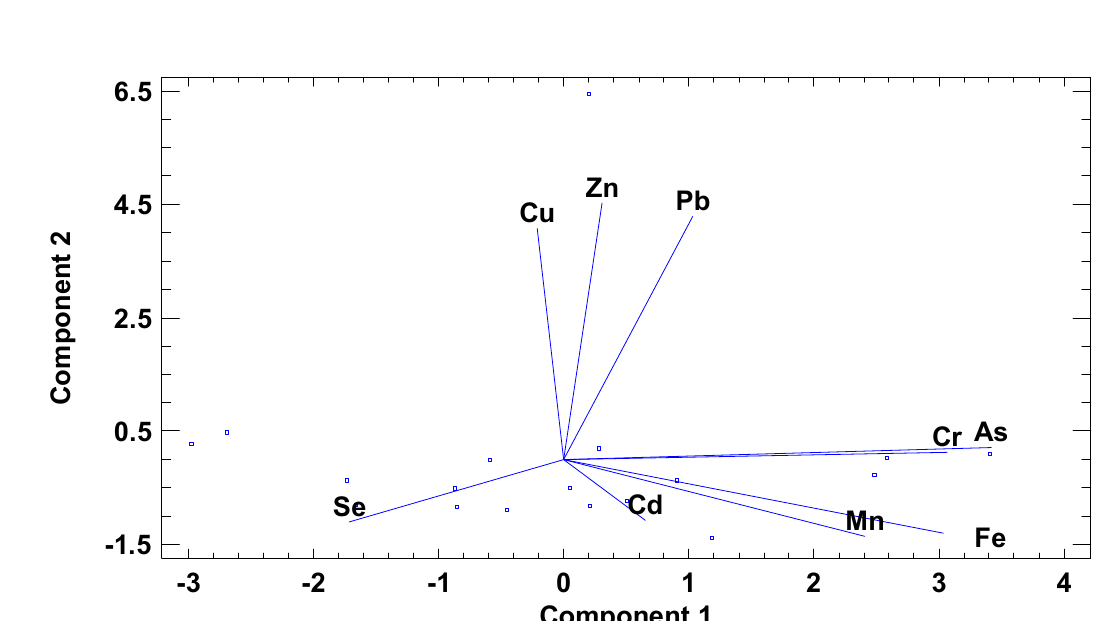
Figure 4. Biplot of the two main components obtained by principal component analysis (PCA) representing both water samples and detected elements. Table 2. Statistics (mean ± standard deviation, minimum, maximum, median ± interquartile range, and lower and upper quartiles) for elements detected ( μ g L –1 ) separated by cardinal points in the Vigo estuary.